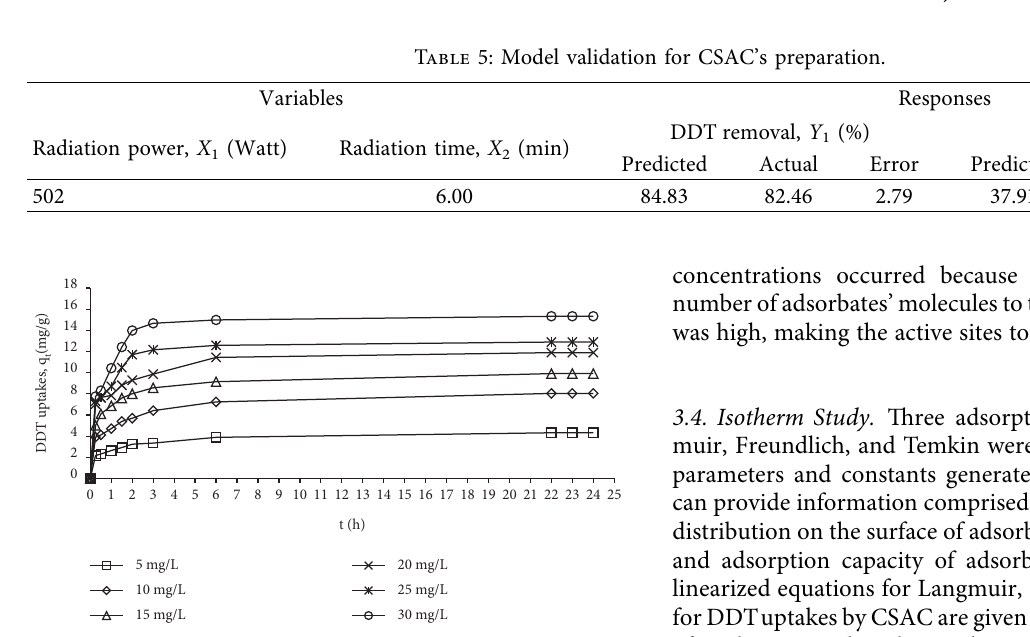
Figure 9: Adsorption uptakes of DDT by CSAC versus time at various initial concentrations (solution temperature of 30 ° C, ad- sorbent dose of 0.2g solution volume of 200mL, and solution pH of 7).